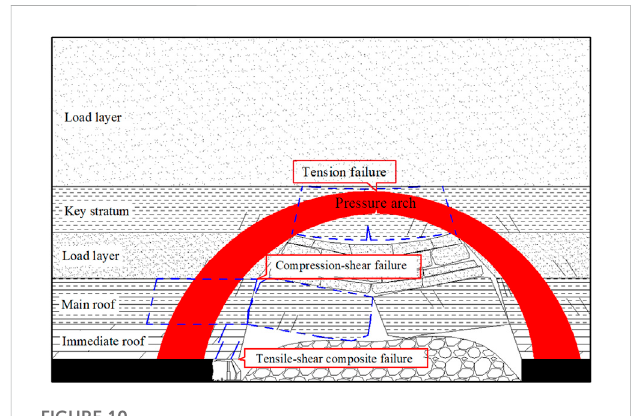
FIGURE 10 Types of instability in the SRPA (Surrounding rock pressure